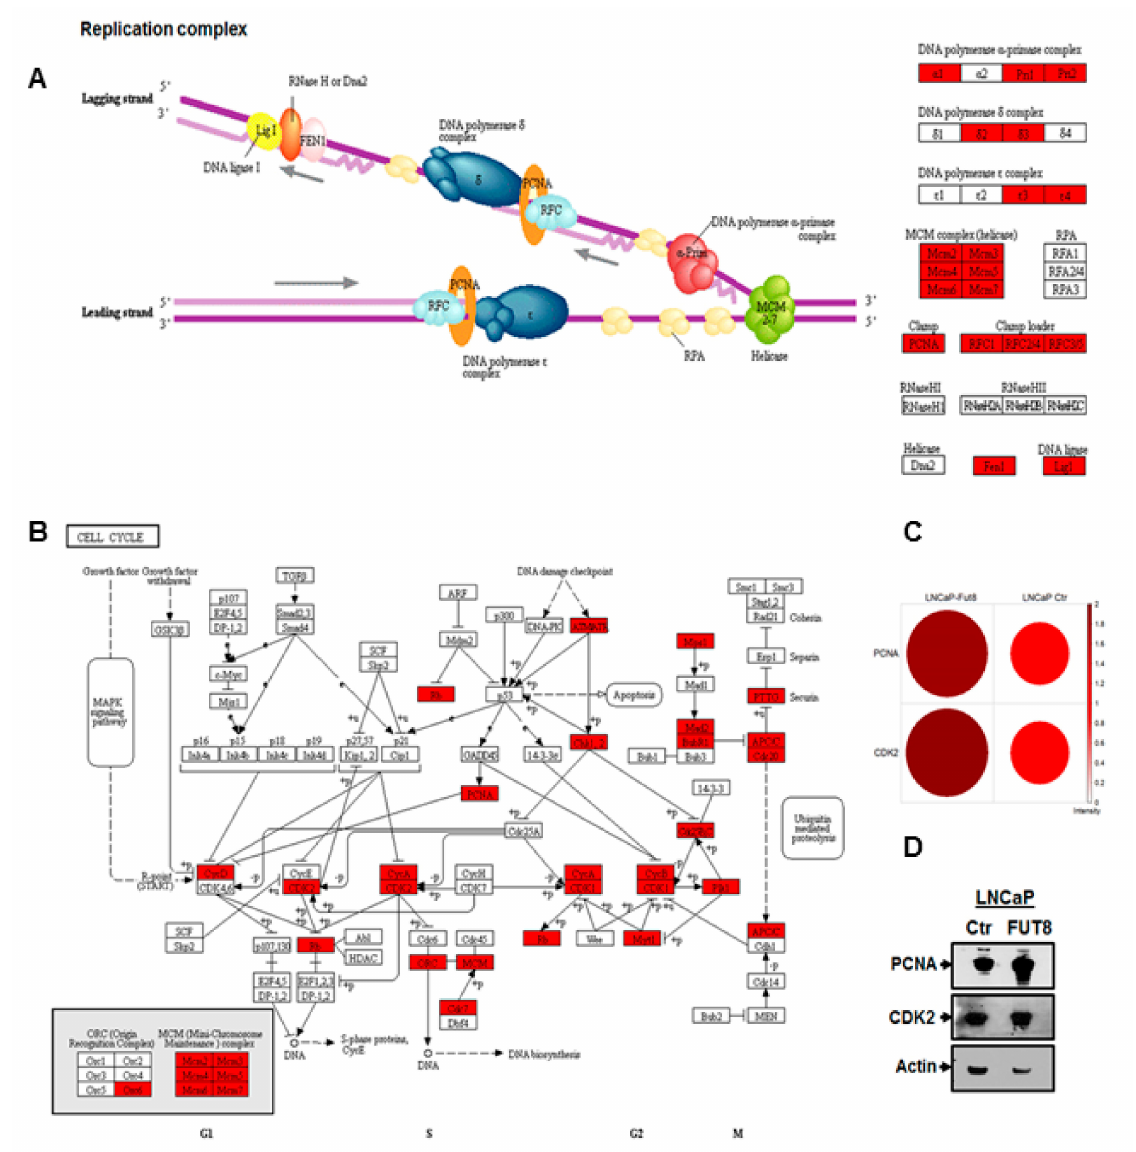
Figure 4. FUT8 overexpression promotes DNA replication. Di ff erentially expressed proteins (1.5-fold upregulated proteins) between LNCaP-FUT8 / LNCaP-Ctr that were identified in our global proteomics analysis were subjected to the Kyoto Encyclopedia of Genes and Genomes (KEGG) pathway analysis. Several proteins including the subunits of DNA polymerase alpha primase complex, DNA polymerase delta and epsilon along with minichromosome maintenance (MCM) and proliferation cell nuclear antigen (PCNA) were identified in LNCaP-FUT8 cells compared to the wildtype control ( A ). The same 1.5-fold upregulated proteomics data were analyzed for cell cycle analysis showing overexpression of many S phase and G2 / M cell phase cycle proteins ( B ). Bubble blot showing the expression of PCNA and CDK2 expression correlation between the two LNCaP-FUT8 and LNCaP Ctr cell lines ( C ). Western Blot analysis showing PCNA and CDK2 expression between the LNCaP Ctr and LNCaP-FUT8 cell lysate. Actin was included that accounted for the amount of loading across lanes ( D